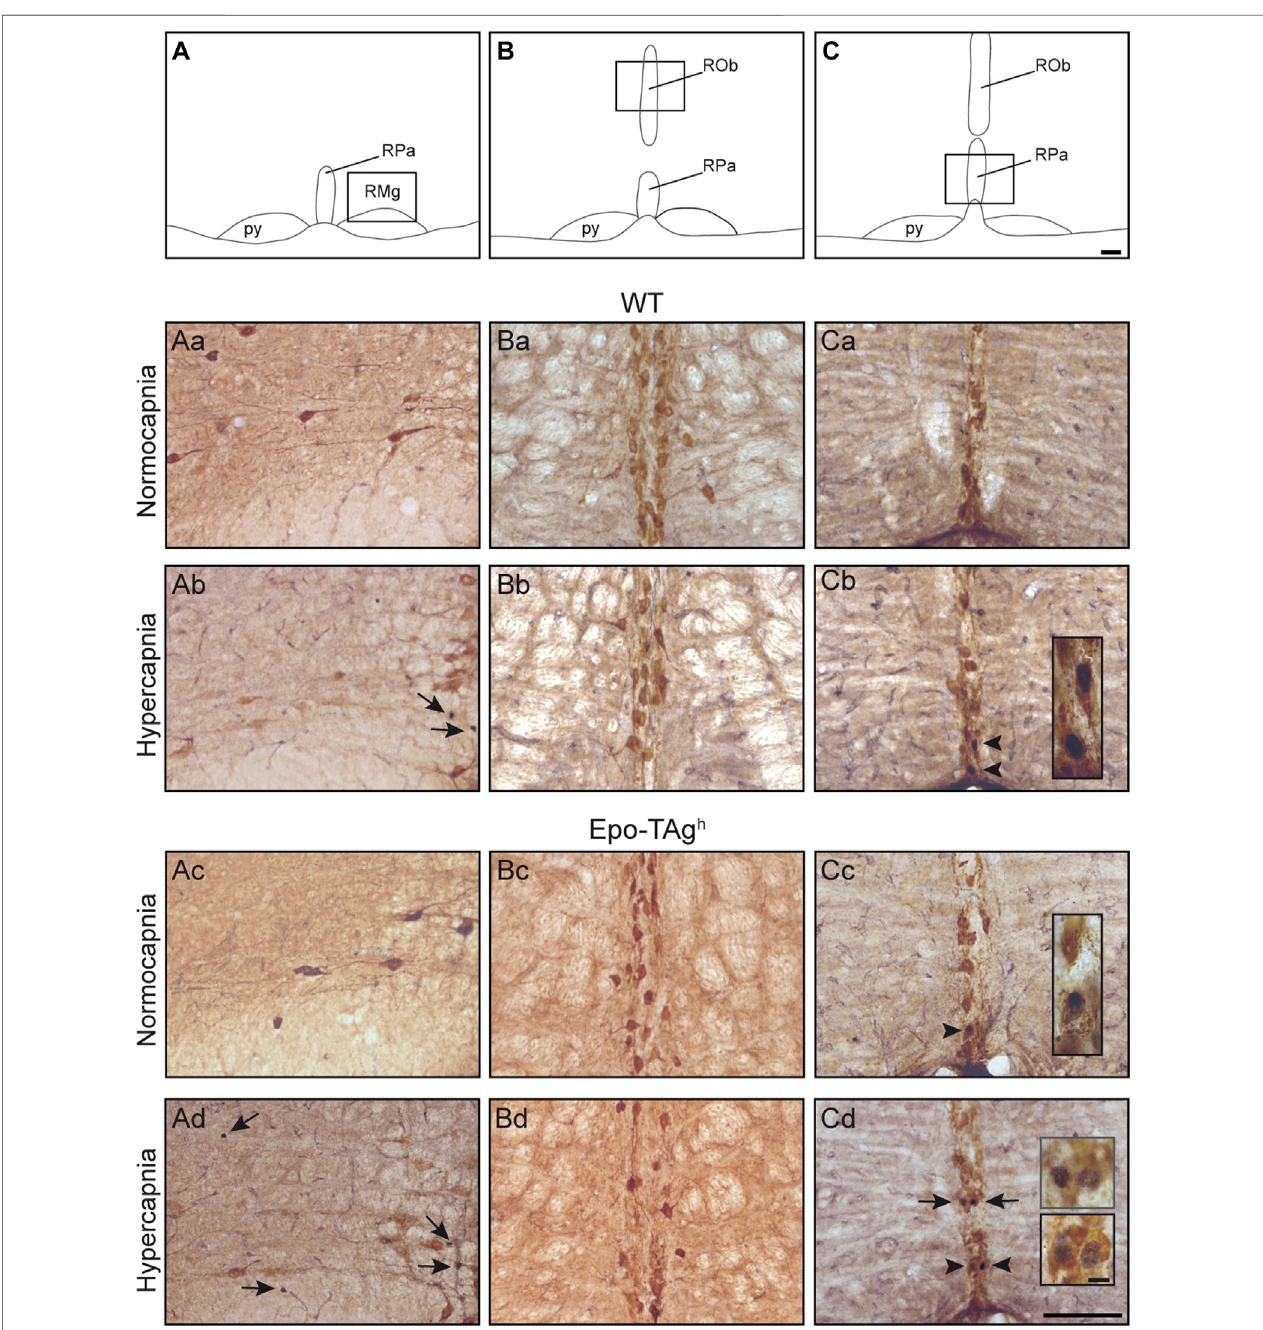
FIGURE 3 | Serotoninergic character of hypercapnic c-FOS positive cells in medullary raphe nuclei. Drawings of the medulla oblongata locating 5-HT structures illustratedin themicrophotographs below, raphe magnus (A) , rapheobscurus (B) , and raphepallidus nucleus (C) nuclei.Scale bar =100 μ m. Theblackbox de fi nes the photographed areas. Photomicrographs of sections dually immunolabelled for c-FOS and 5-HT in WT (Aa,Ba,Ca,Ab,Bc,Cb) and Epo-Tag h (Ac,Bc,Cc,Ad,Bd,Cd) mice in raphe magnus nucleus (Aa – Ad) under normocapnia (Aa,Ac) and hypercapnia (Ab,Ad) , in raphe obscurus nucleus (Ba – Bd) under normocapnia (Ba,Bc) and hypercapnia (Bb,Bd) ,and innucleus pallidus nucleus (Ca – Cd) undernormocapnia (Ca,Cc) andhypercapnia (Cb,Cd) .Blackarrows showc-FOSpositiveneurons and black arrowheads (Cb,Cd) show c-FOS/5-HT-positive neurons. Scale bars = 100 µm. High magni fi cation in (Cb – Cd) , scale bar = 10 μ m. Abbreviations: py, pyramidal tract; RMg, raphe magnus nucleus; ROb, raphe obscurus nucleus; RPa, raphe pallidus nucleus.